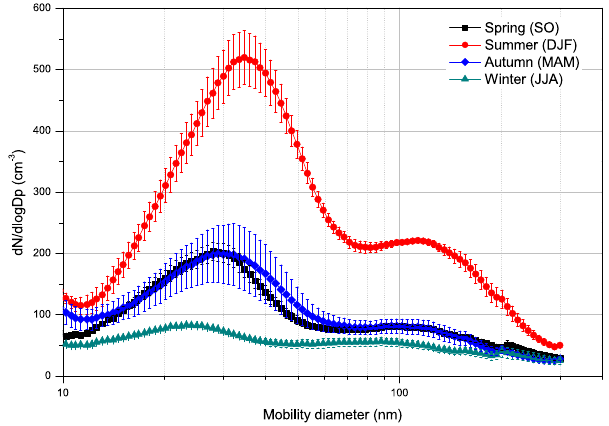
Figure 8. Seasonal mean aerosol size distribution measured by the SMPS at the King Sejong research station over the period from March 2009 to February 2015. The error bars represent the stan- dard deviation of the measurements from the mean